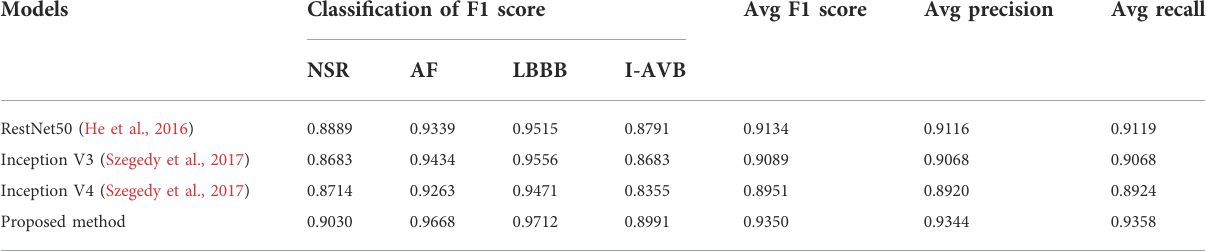
TABLE 5 Comparison of different reference models for CA Classi fi cation. Models